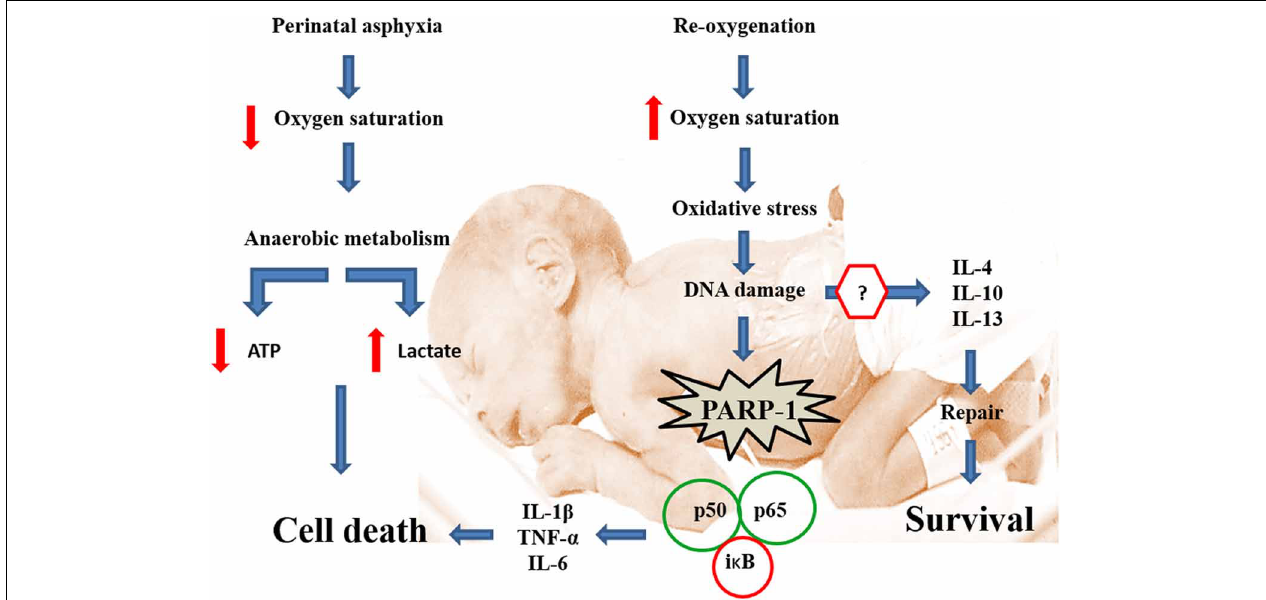
FIGURE 2 | Transcriptional activation of pro-inflammatory signaling in tandem with PARP-1 overactivation. Perinatal asphyxia decreases oxygen saturation in blood, leading to a switch from aerobic to a less efficient anaerobic metabolism involving lactate accumulation, acidosis and cell death. Re-oxygenation is essential for survival. Nevertheless, re-oxygenation induces oxidative stress, damaging several biomolecules including DNA. In response to DNA damage, PARP-1 increases its activity,